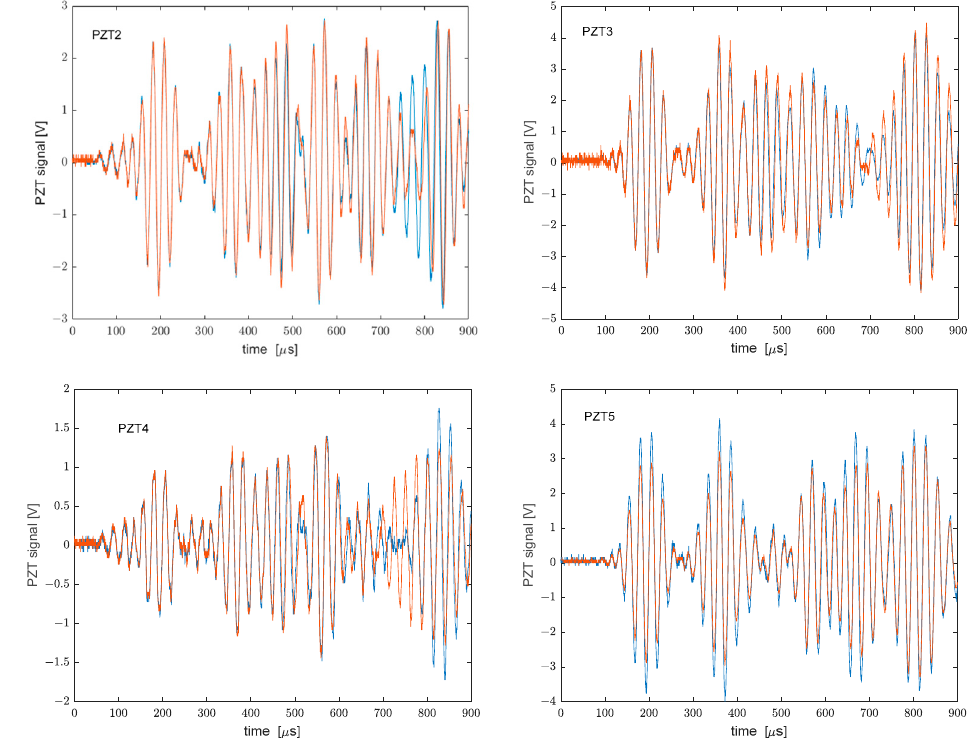
Figure 7. Distributed strain measurement along the optical fiber strands OFS1 and OFS3 with the plate in the cantilevered state.